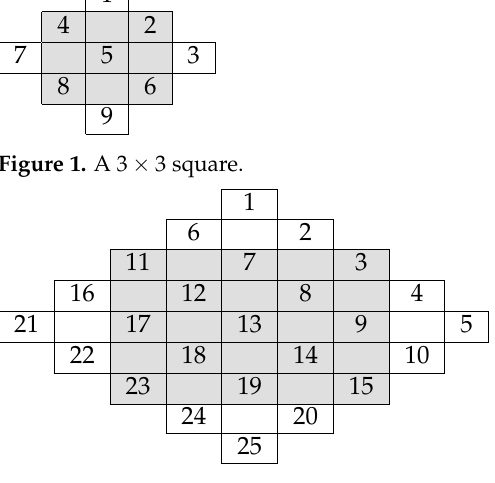
Figure 2. A 5 × 5 square.